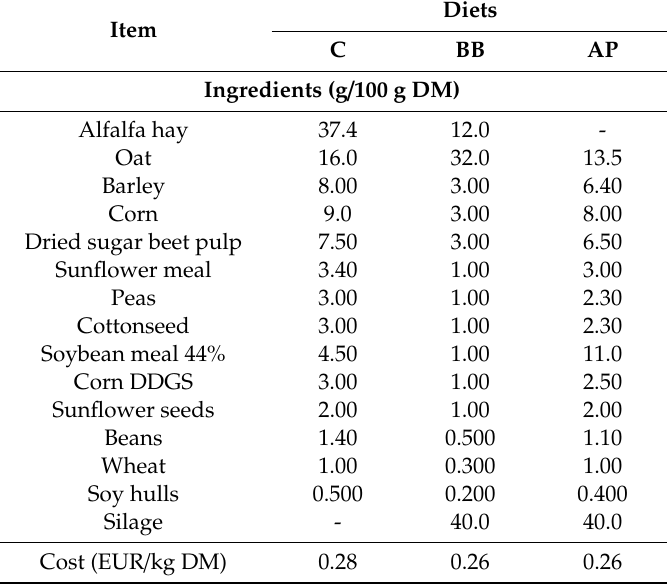
Table 1. Ingredients and chemical composition of the experimental diets provided to goats of the present